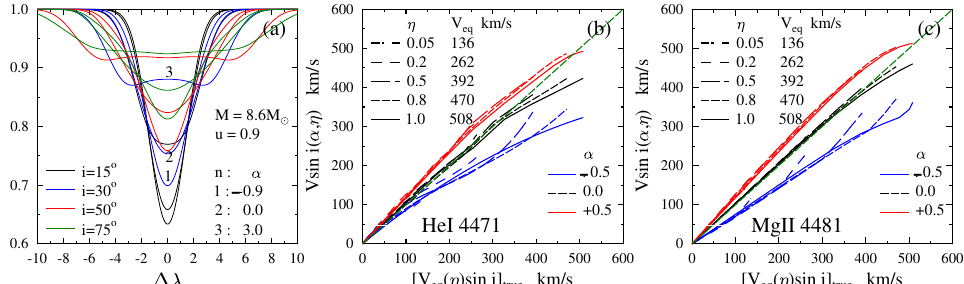
Figure 27. ( a ) Gaussian absorption lines broadened by rotation, whose intensity and equivalent width depend on the effective temperature and gravity, as does the HeI4471 transition. The gravitational darkening is calculated for an object of mass M / M (cid:12) = 8.6 and fractional age t / t MS = 0.5 rotating at the equator with u = V / V c = 0.9. The angular velocity law used in the calculations is given by Equation (45). The colors indicate inclination angles, but in this figure, only the i = 30 o (blue) corresponding to different values of α are explicitly identified. ( b ) Measured V sin i parameters in km s − 1 by means of the FT technique of the HeI4471 line broadened by differential rotation characterized by the different values of the parameter α in an object having T eff = 23,000 and log g = 4.1 rotating at different rates η . In abscissas, there are the true equatorial V sin i for the same rates η . ( c ) Idem for the MgII4481 line. Adapted from Zorec et al.